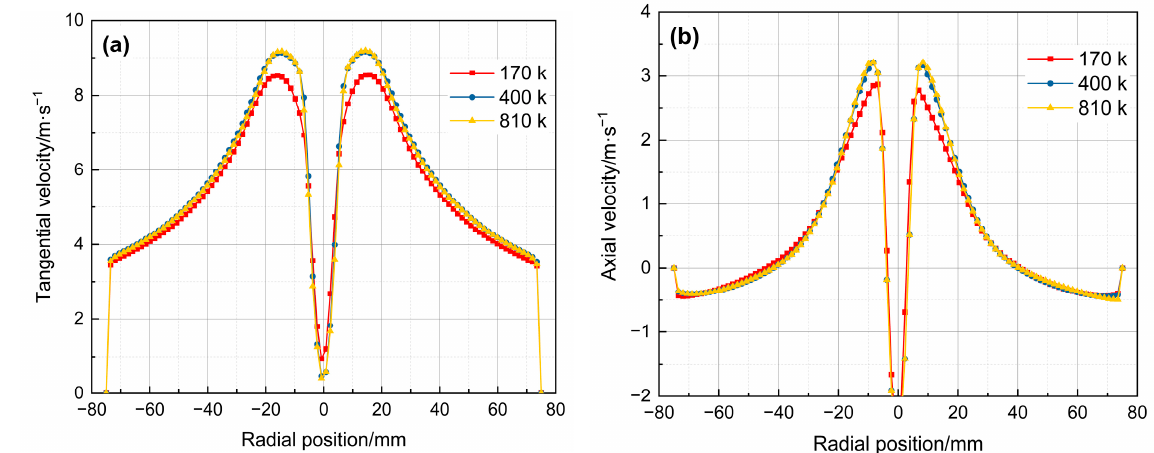
Figure 2. Schematic diagram of laboratory Φ 150 mm hydrocyclone. ( a ) Geometrical parameters; ( b ) Computational mesh.